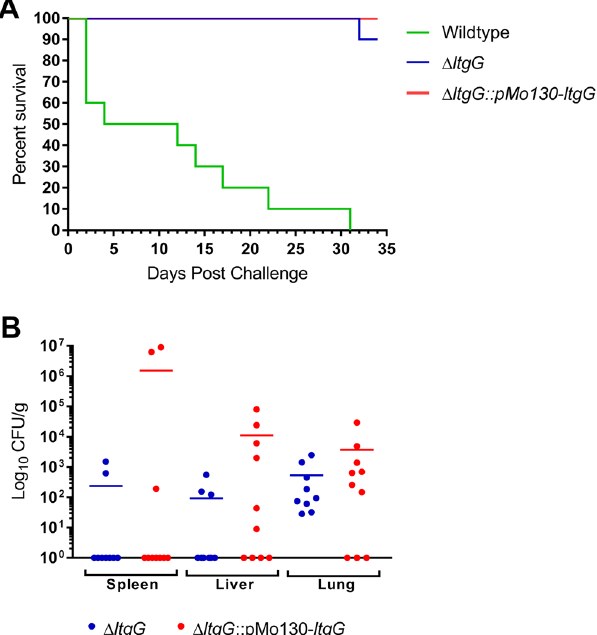
Figure 5. B . pseudomallei ∆ ltgG is significantly attenuated in the IP BALB/c mouse model of infection. ( A ) Mice challenged with approx. 2 × 10 4 CFU were monitored over 35 days. Mice challenged with ∆ ltgG had a 90% survival. Mantel-Cox Log Rank test value of 0.001. ( B ) Organ counts from surviving mice revealed low levels of bacteria primarily in the